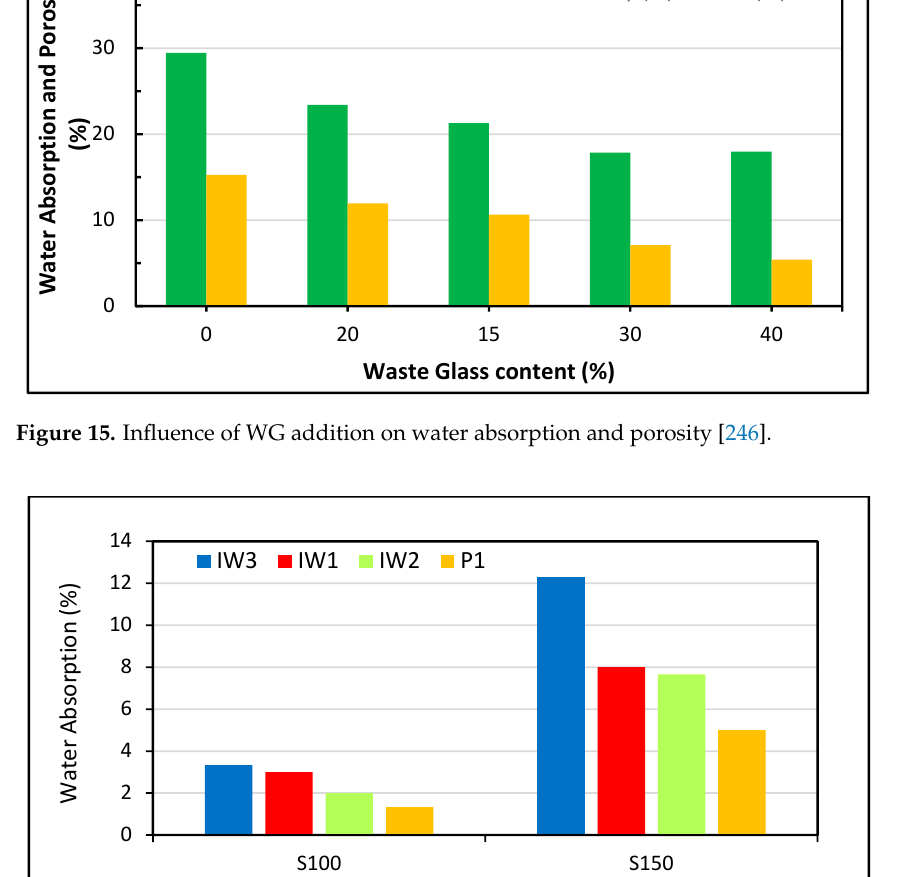
Figure 17. Water absorption of a concrete mix at various polymer to cement ratios [251].